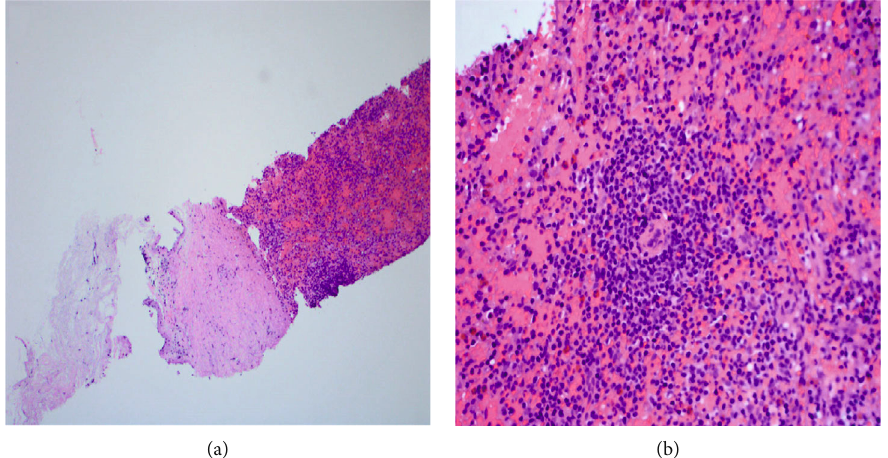
Figure 3: Pathology fi ndings of the left pleural nodule showing (a) splenic tissue with a thick collagen band representing the splenic capsule (H&E stain, 100x). (b) Splenic tissue with congested blood- fi lled sinuses representing red pulp and lymphoid aggregates surrounding vascular structures representing white pulp (H&E stain,